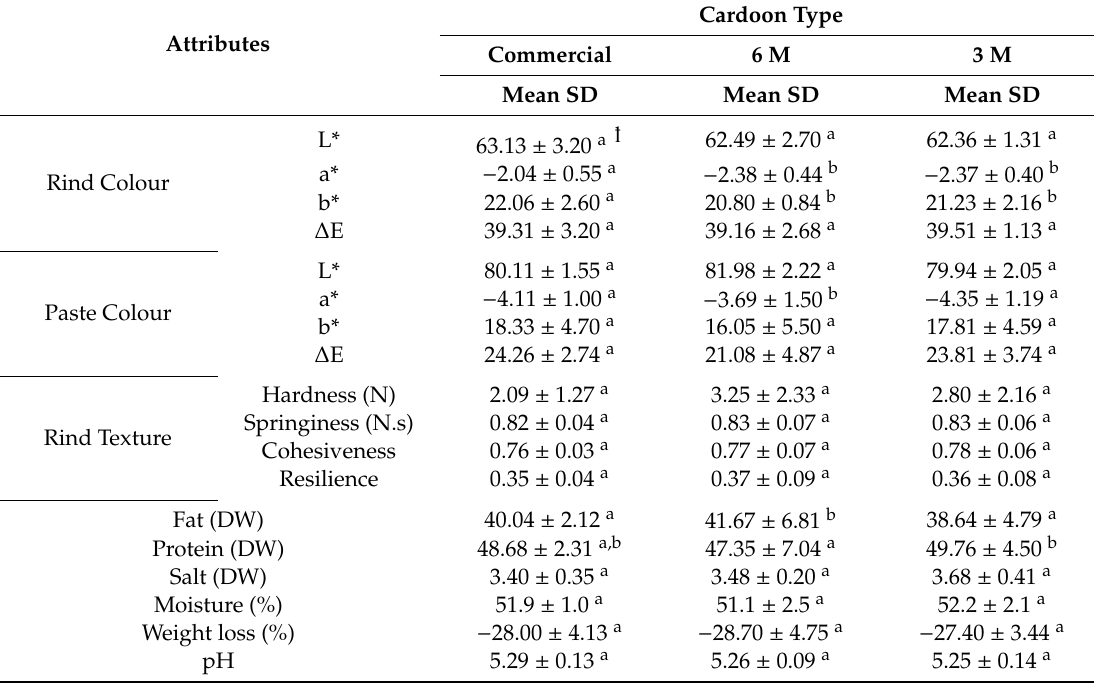
Table 3. The influence of cardoon flower type (commercial, 6 M and 3 M) in the physicochemical attributes of cheeses, accessed by analysis of variance. SD-standard deviation